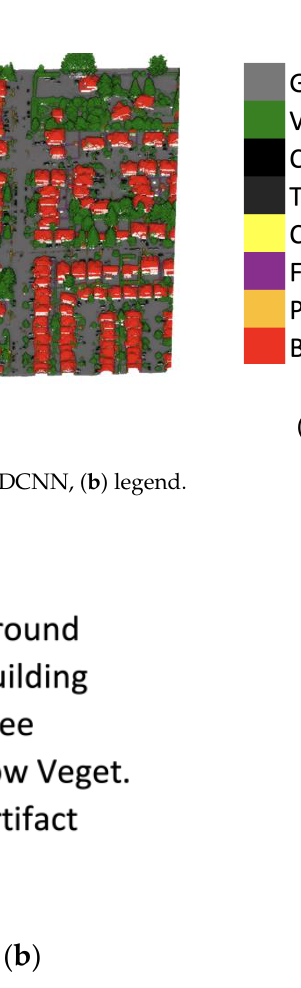
Figure 13. ( a ) Classification result of the ISPRS Vaihingen dataset with the 2DCNN approach. ( b ). Legend Table 8. Average and weighted F1 and IoU scores for 2DCNN and 3DCNN classifiers on the DALES dataset. The OA is also reported.